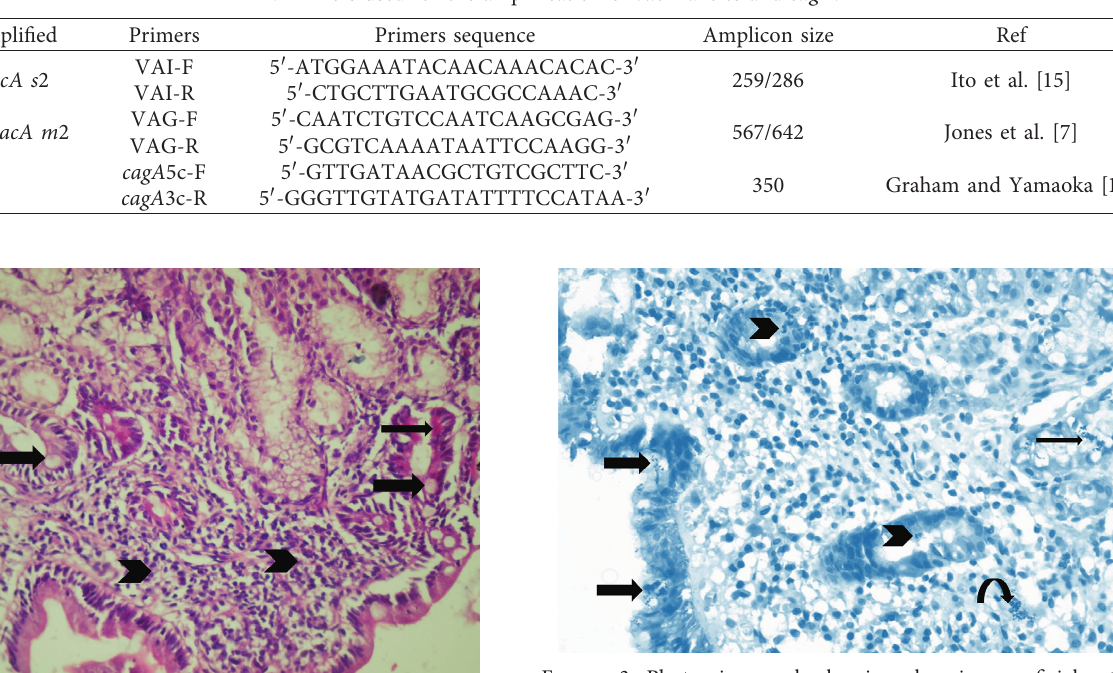
Table 1: Primers used for the amplification of vacA alleles and cagA .